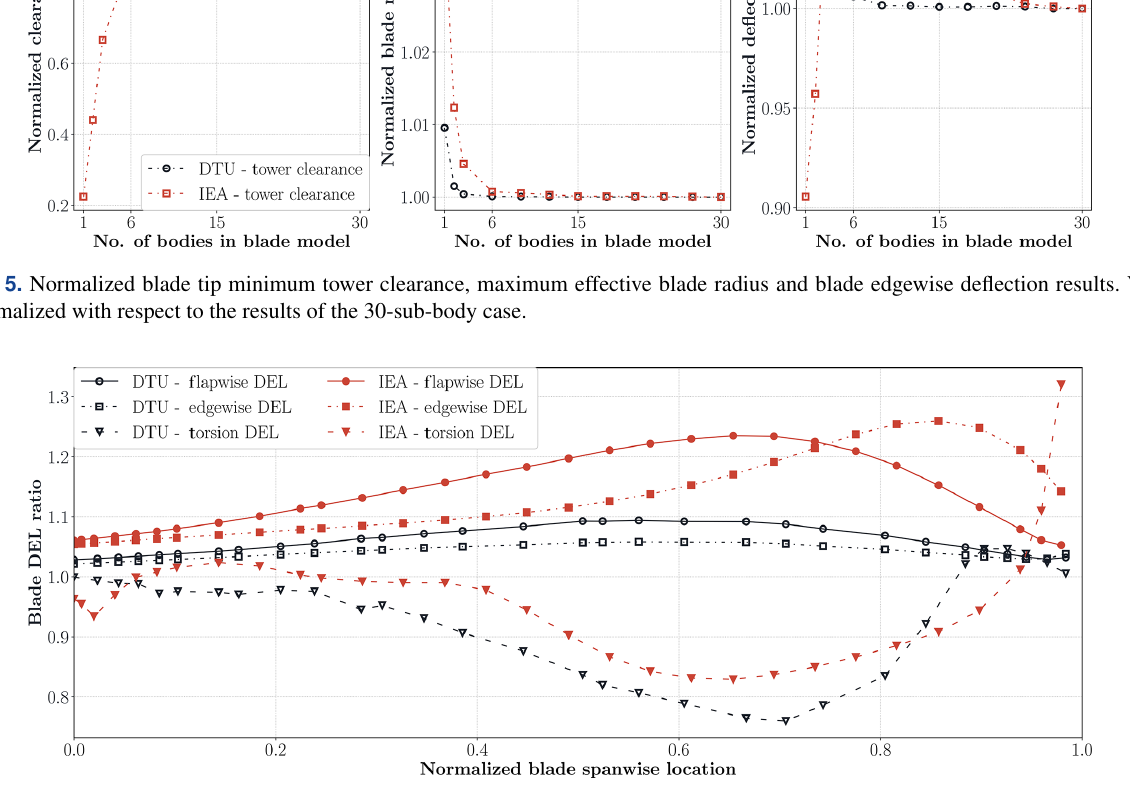
Figure 6. Flapwise, edgewise and torsion moment DEL ratios between linear (one sub-body) and nonlinear (30 sub-bodies) blade model over the normalized blade span for the DTU10MW and IEA10MW